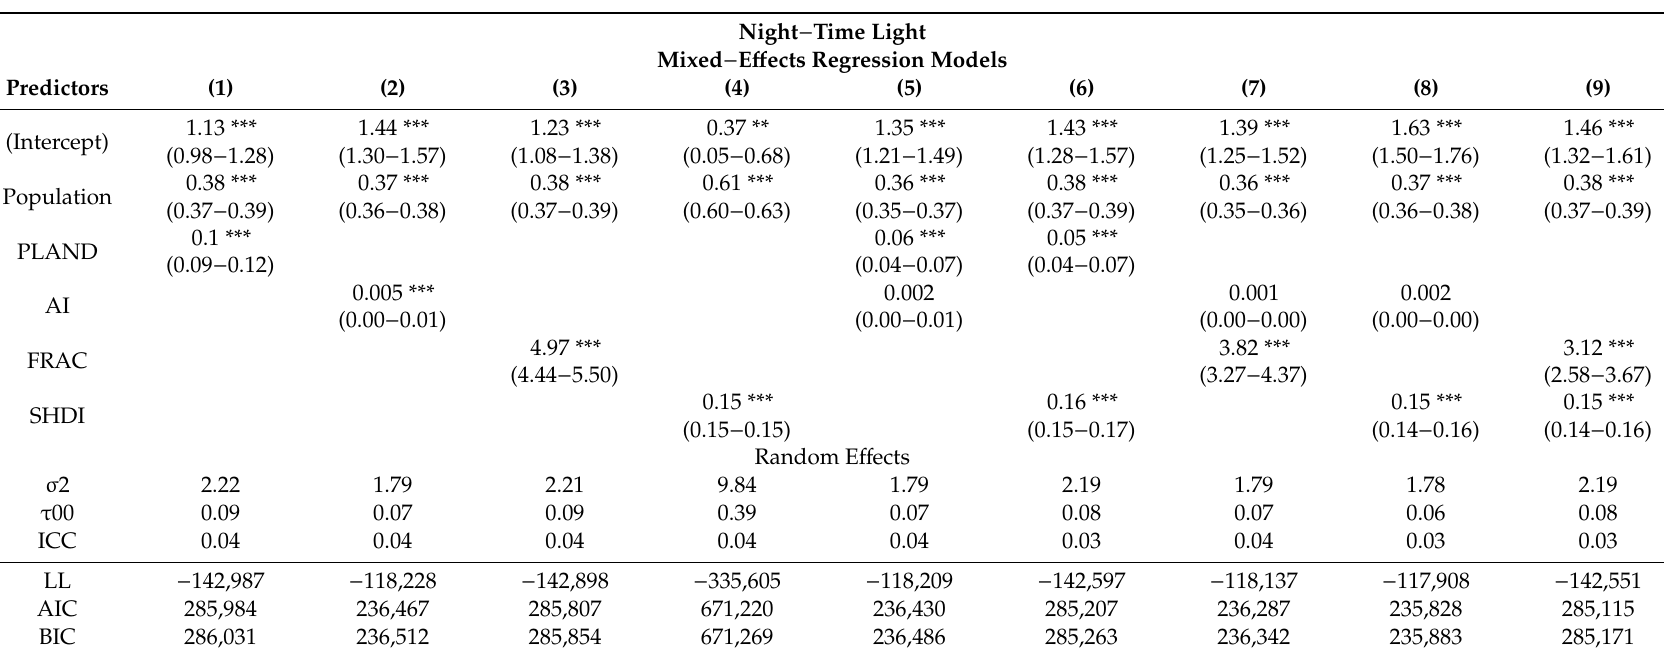
Table 2. Multivariate mixed-e ff ects regression models for estimating night-time lights. Models with one landscape metric (models 1–4) and two landscape metrics (models 5–9) were estimated with 95% confidence intervals